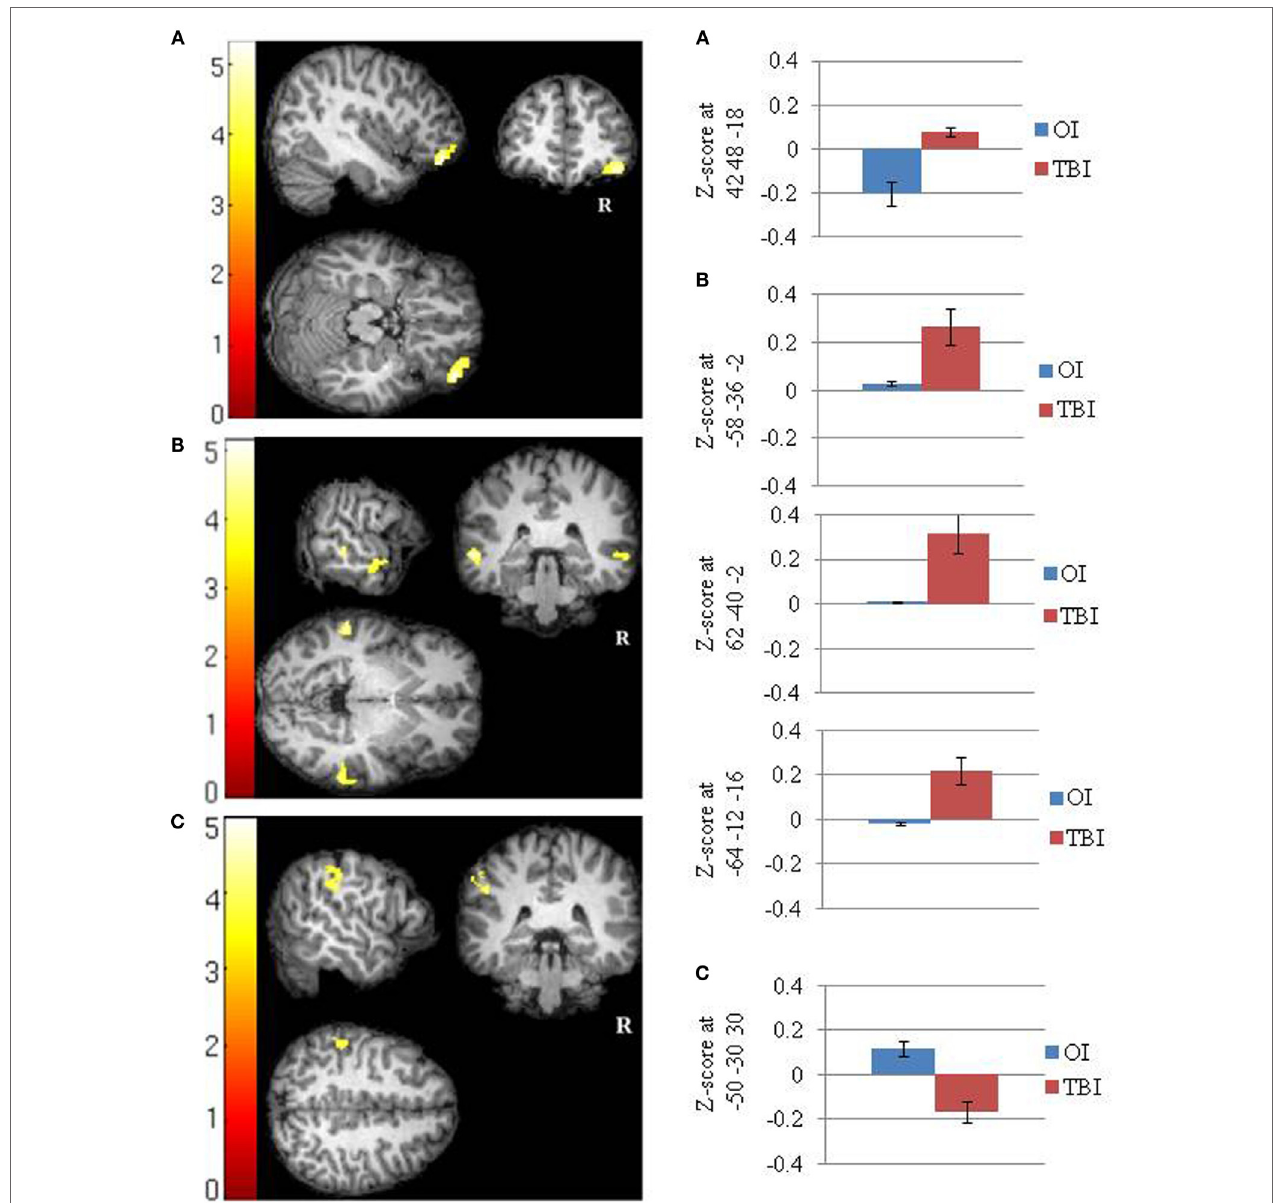
FigUre 1 | significant between groups differences in the functional connectivity of the default mode network in (a) the posterior cingulate cortex (src > Oi), (b) the right lateral parietal cortex (src > Oi), and (c) the right lateral parietal cortex (Oi > src) . Mean Fisher transformed z -scores and their standard errors associated with each cluster are also depicted. Right side of brain is on right side of